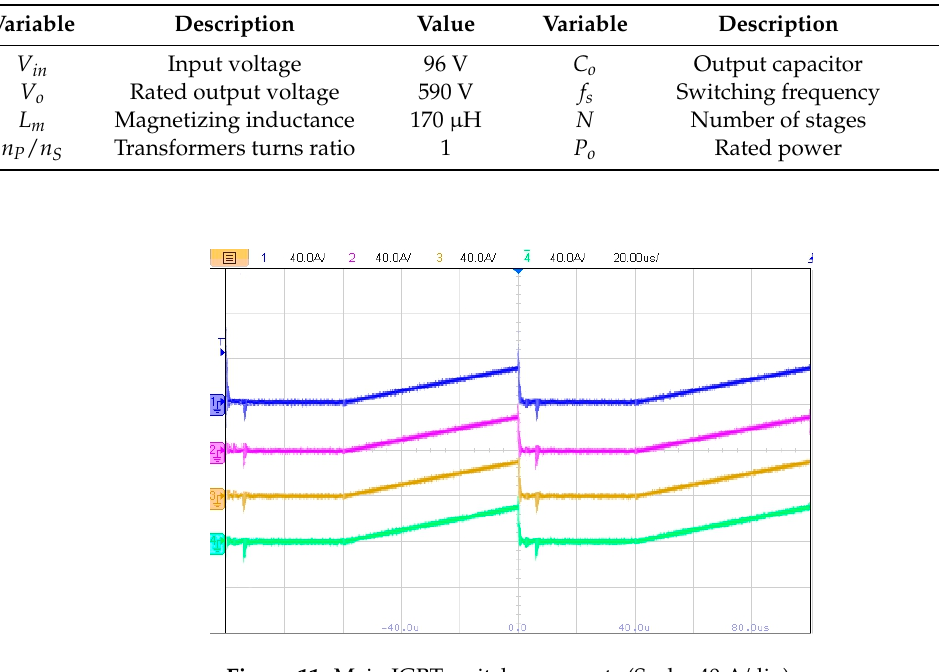
Figure 11. Main IGBT switches currents (Scale: 40 A/div).